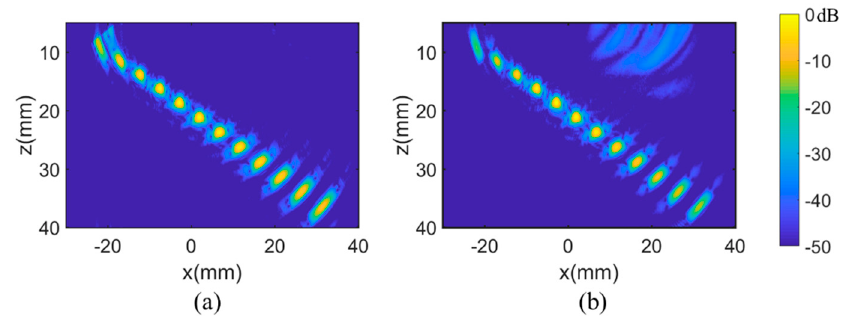
Figure 5. Simulated images obtained by the ( a ) PWI and ( b ) total focusing method (TFM) algorithms.